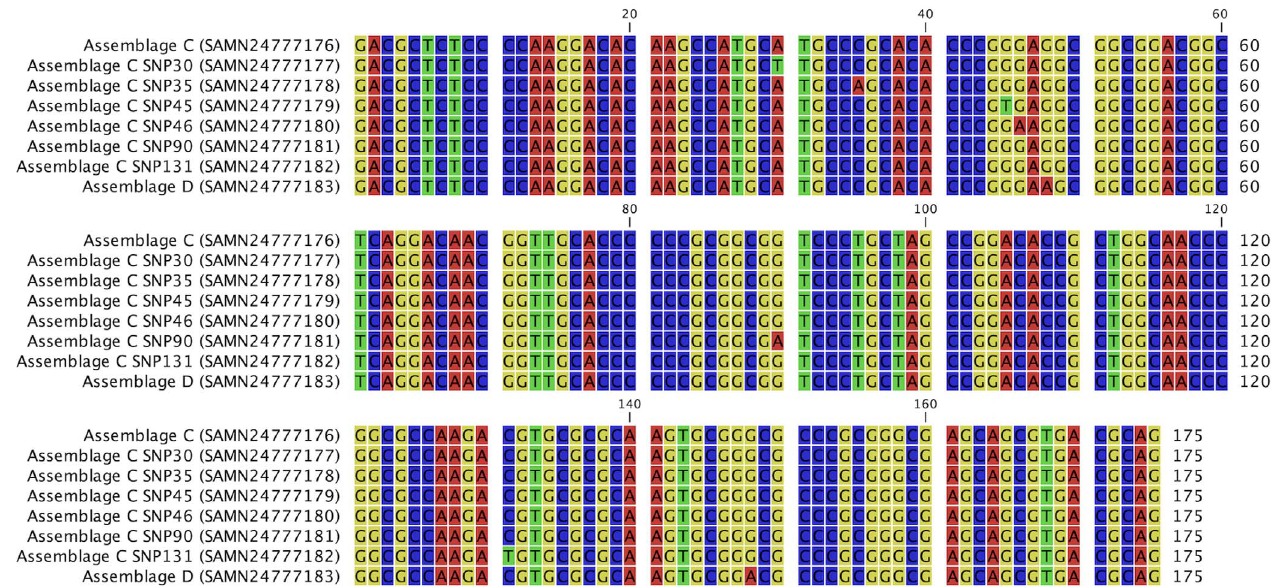
Figure 3. Sequences of assemblage C, assemblage C with nucleotide substitutions and assemblage D obtained at the SSU r DNA gene locus. GenBank references are written in brackets. SNP: single nucleotide